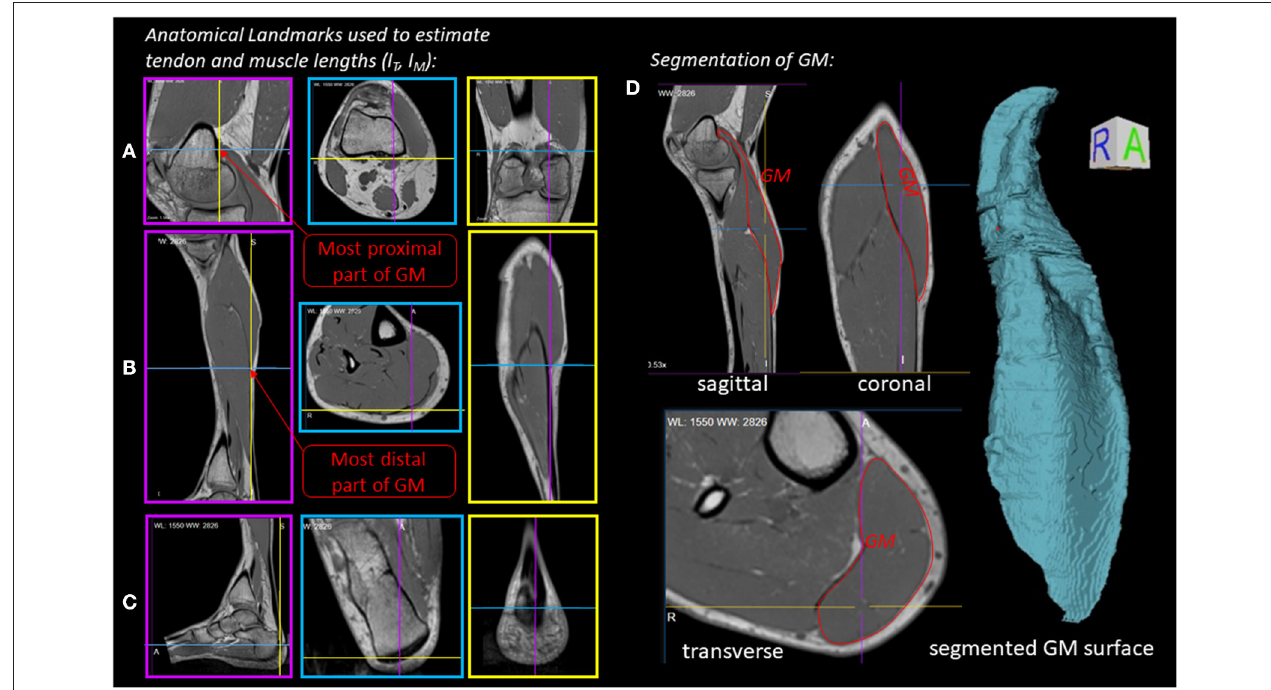
FIGURE 2 | Experiment 1—Determination of muscle morphology: (A–C) Sagittal (magenta boxes), transverse (blue boxes) and coronal (yellow boxes) MRI planes illustrating anatomical landmarks (indicated by line cross-sections), which were identified to determine the tendon ( l SEE ) and muscle lengths ( l CE ). (D) Manually segmented GM muscle and corresponding GM